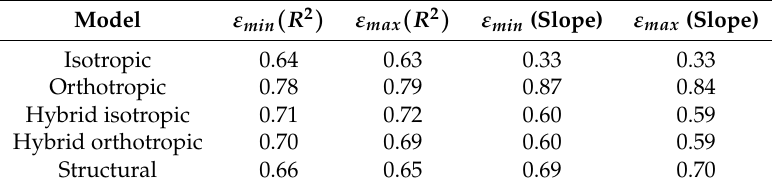
Table 5. Coefficients of determination and slopes of the line of best fit for each adaptive model compared to the CT scan derived model. A slope value of 1 means a perfect match between models.